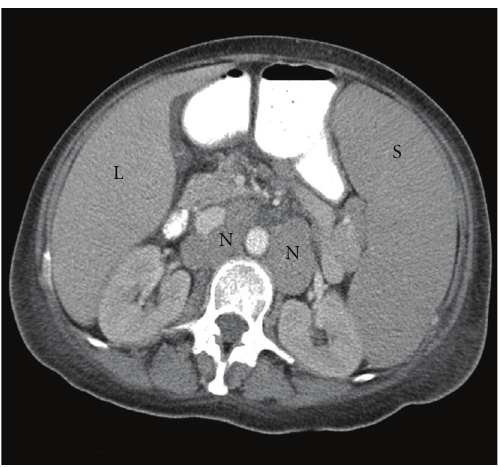
Figure 1: Computed tomography scan of the abdomen showed massive splenomegaly and extensive lymphadenopathy . (L: liver, S: spleen, N: lymphadenopathy).